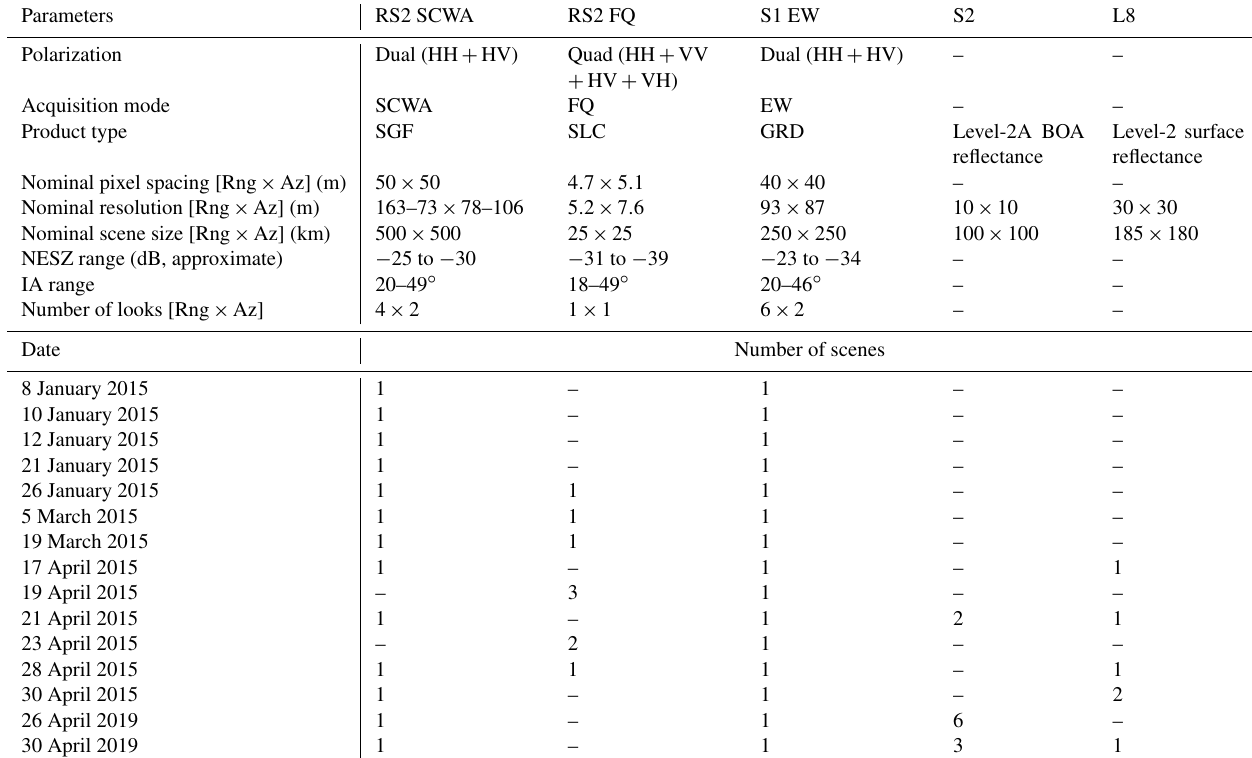
Table 1. Parameters of satellite data used in this study. SGF: SAR georeferenced fine; SLC: single look complex; GRD: ground range multi- look detected; Rng: range direction; Az: azimuth direction; NESZ: noise-equivalent sigma zero. Spatial resolution of S2 and L8 data is for bands 2, 3 and